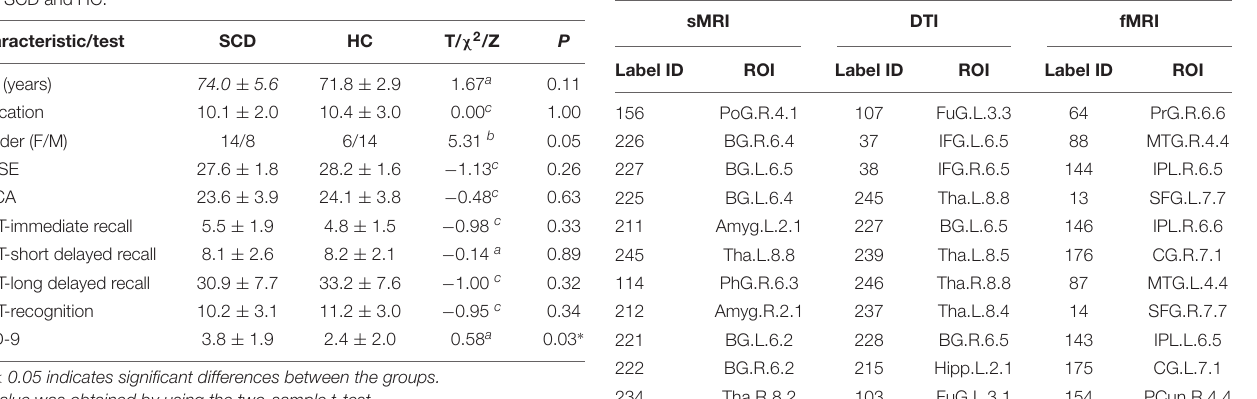
TABLE 2 | Hubs of SCD based on different modal brain network.